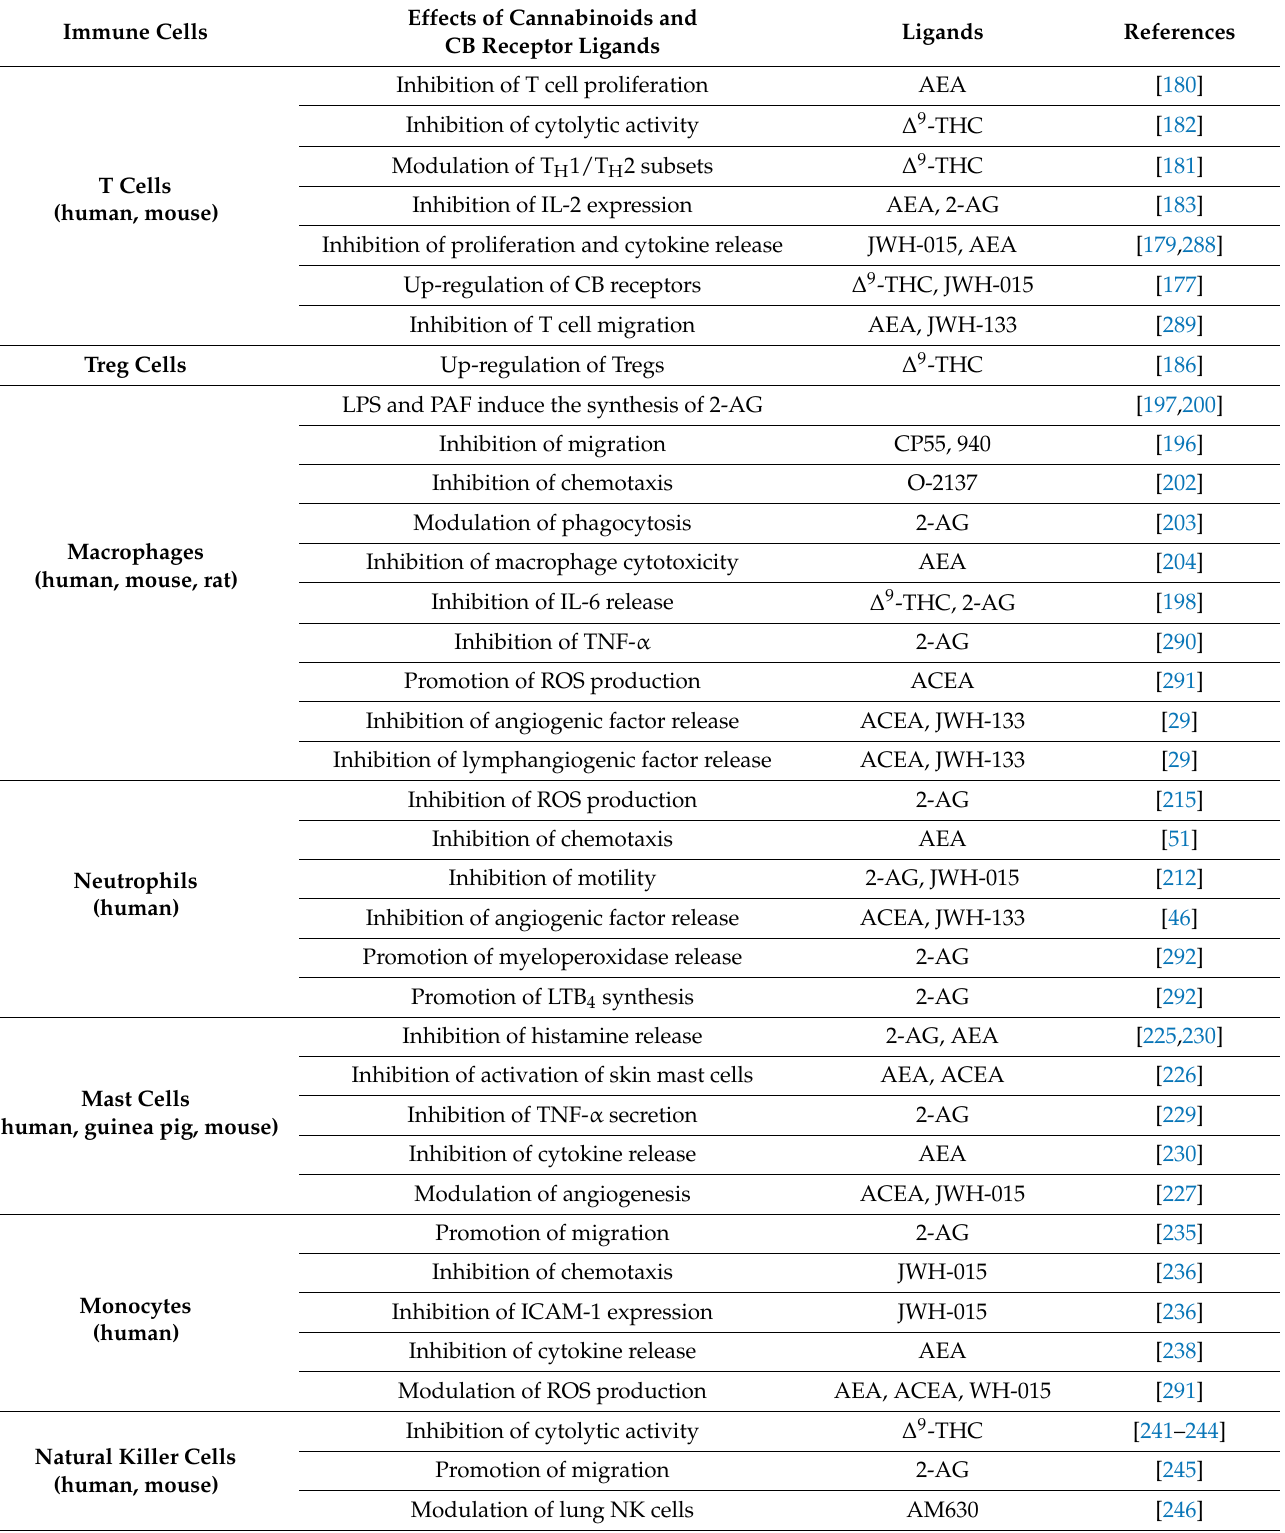
Table 1. Main effects of cannabinoids and CB receptor ligands on cells of innate and adaptive immune system. Immune